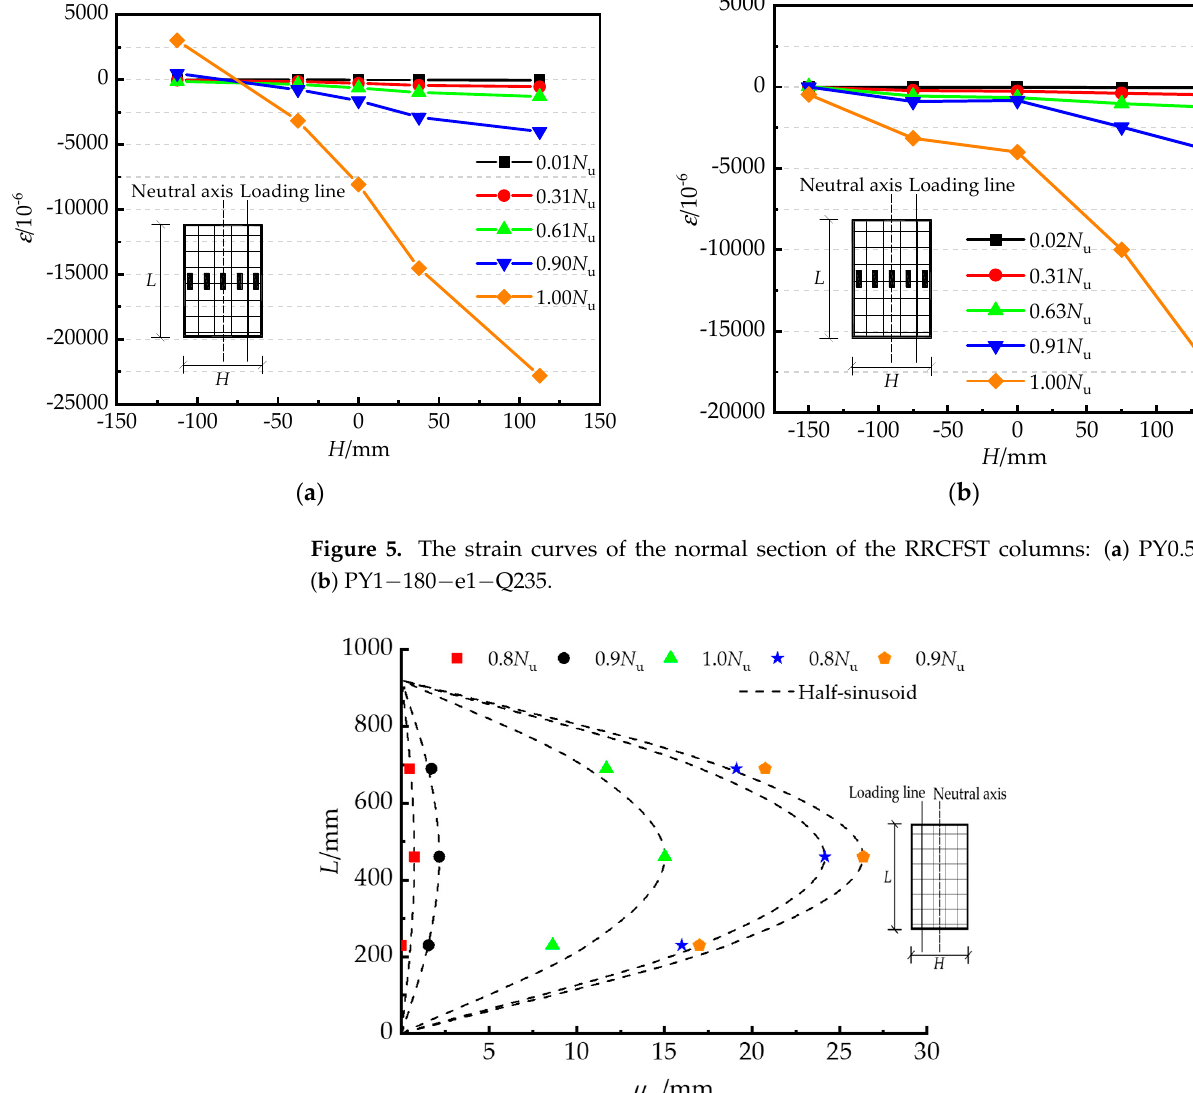
Figure 6. Lateral deflection curve of the typical specimen.